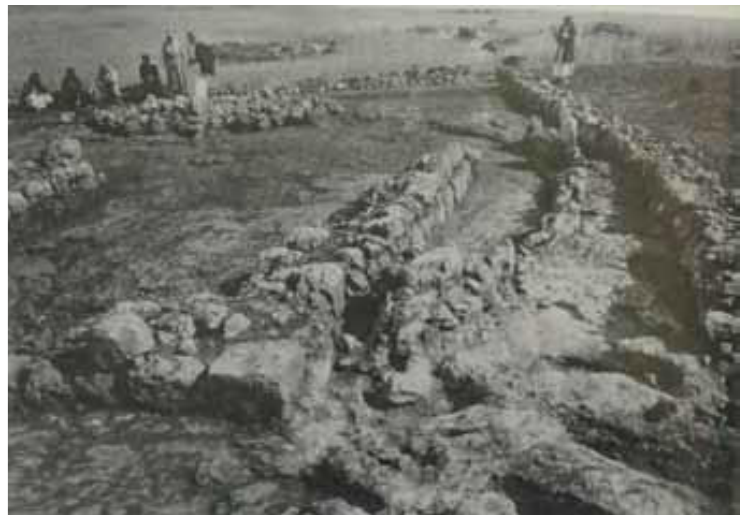
Figure 7. The open-air Weli from south, excavated in 1926, from Andersen 1985, p. 76.